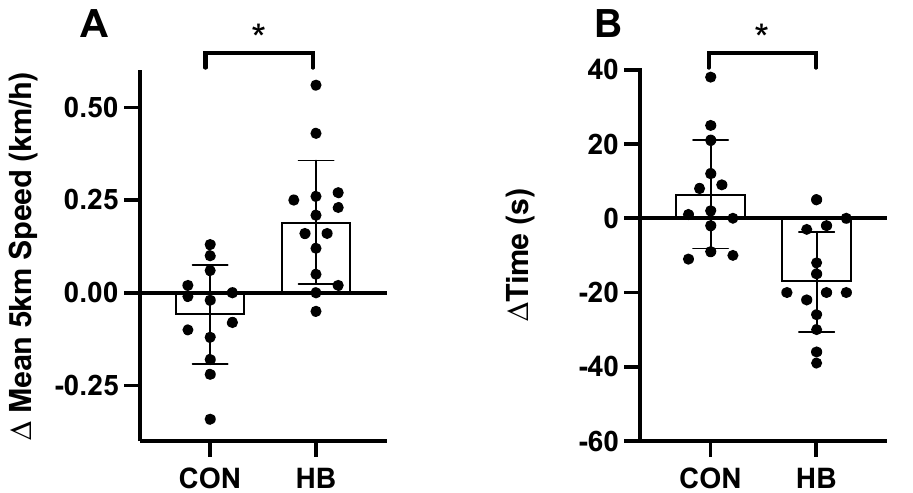
Figure 3. The change in time to mean speed during the 5 km time trial; TT (Panel A ) and the change in 5 km TT performance (Panel B ) in the placebo control (CON; n = 13) and Haskap (HB; n = 14) groups. Data are presented as mean ± SD; * denote significant differences between groups. Table 5. Data from the 5 km time trial (TT) before and after the intervention of Haskap or placebo control.